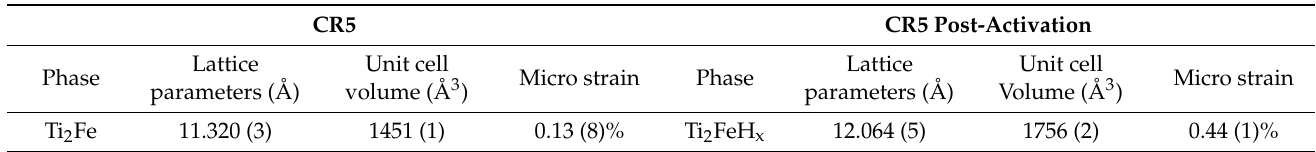
Table 3. Crystal structure parameters of the Ti 2 Fe and Ti 2 FeH x phases identified in Figure 4 (the uncertainty on the last significant digit is given by the number in parentheses).